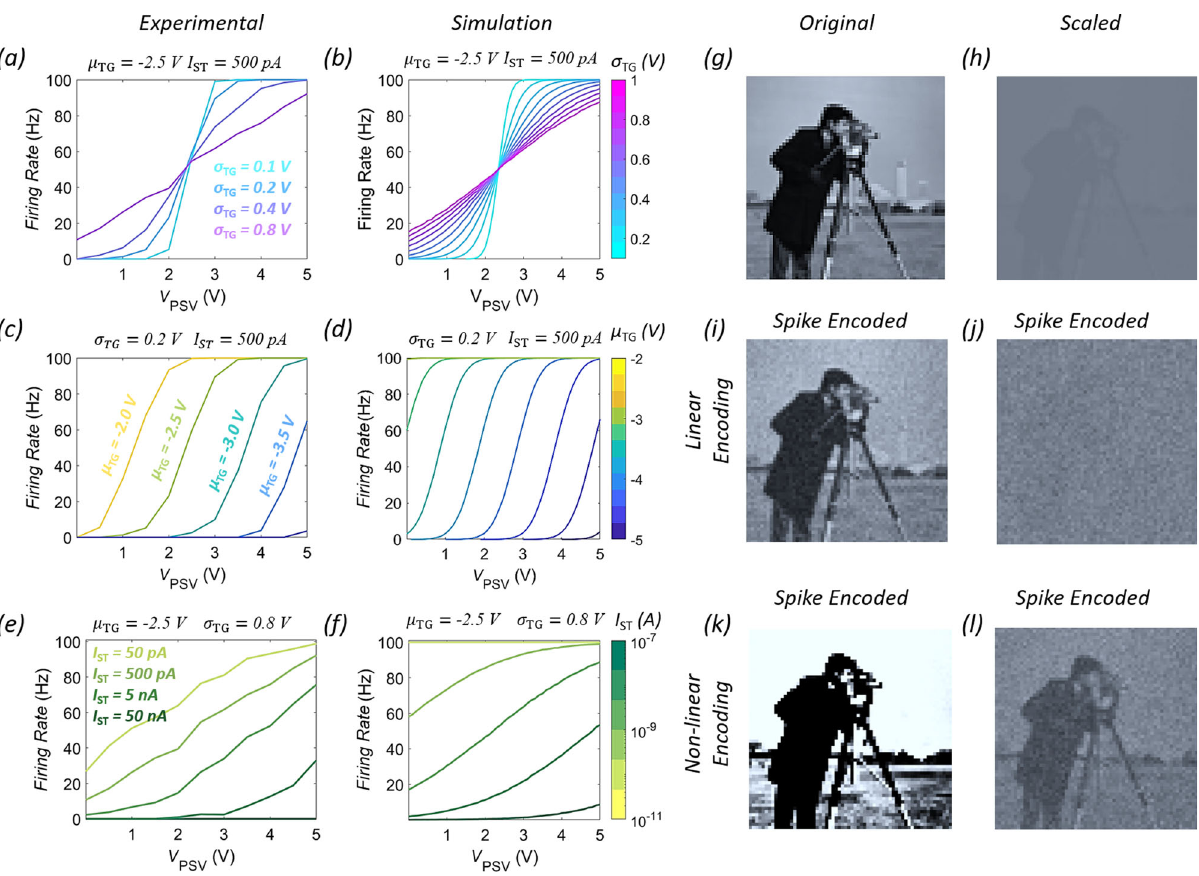
Fig. 4 Dynamic range and encoding precision for rate-based encoding. a Experimental and b virtual source (VS) model-based simulation of fi ring rate as a function of V PSV , for different σ TG . of the Gaussian distribution used for sampling V TG . A high dynamic range (HDR) can be achieved by using higher values of σ TG , whereas smalle. r values of σ TG . allow high precision (HP). However, both feats cannot be achieved at the same time by adjusting σ TG . c Experimental and d VS model-based simulation of fi ring rate as a function of, V PSV , for different mean ( μ TG ) of the Gaussian distribution used for sampling V μ TG . By adjusting TG it possible to achieve HP for different ranges of stimulus intensity like the sensory neurons. e Experimental and f VS model-based simulation also show that the fi ring rate can be tuned by adjusting I ST . Lower values of I ST allow more spiking events for any given V PSV , whereas, higher values of I ST restrict. s spiking even for higher V PSV . g Original and h scaled Cameraman images. Corresponding spike rate-based i, j linear and k , l non- linear encoding using our biomimetic encoder. The original Cameraman image necessitates linear encoding since the pixel values have large dynamic range, whereas, the scaled Cameraman image is better encoded using high precision non-linear encoding.